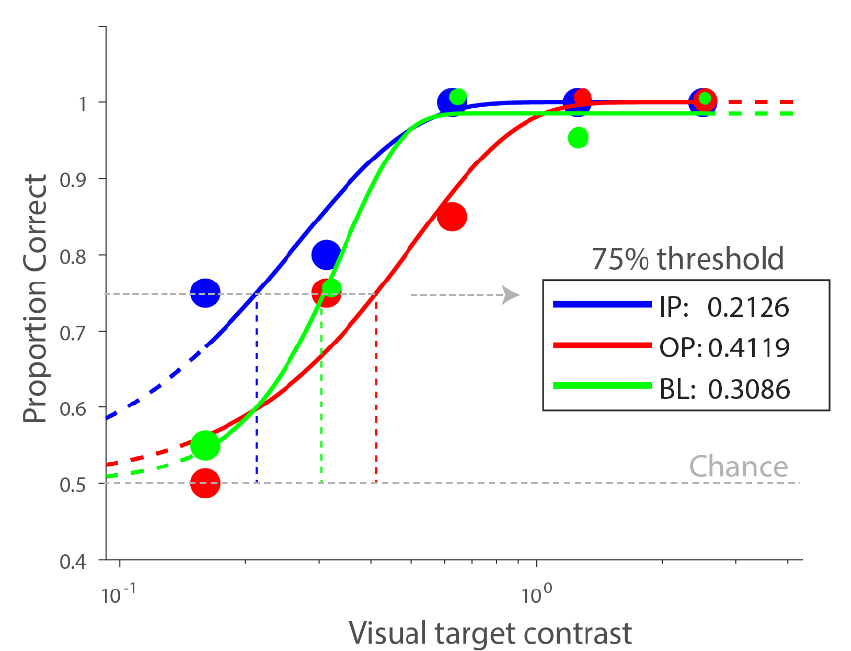
Figure 2. Psychometric functions of baseline (BL), in-phase (IP) (mid-salience), and out-of-phase (OP) (mid-salience) conditions from a representative participant showing the expected effect: estimated visual contrast threshold is the lowest for IP, then BL, then OP condition. The size of individual dots is adjusted so that overlapping data points are more visible.